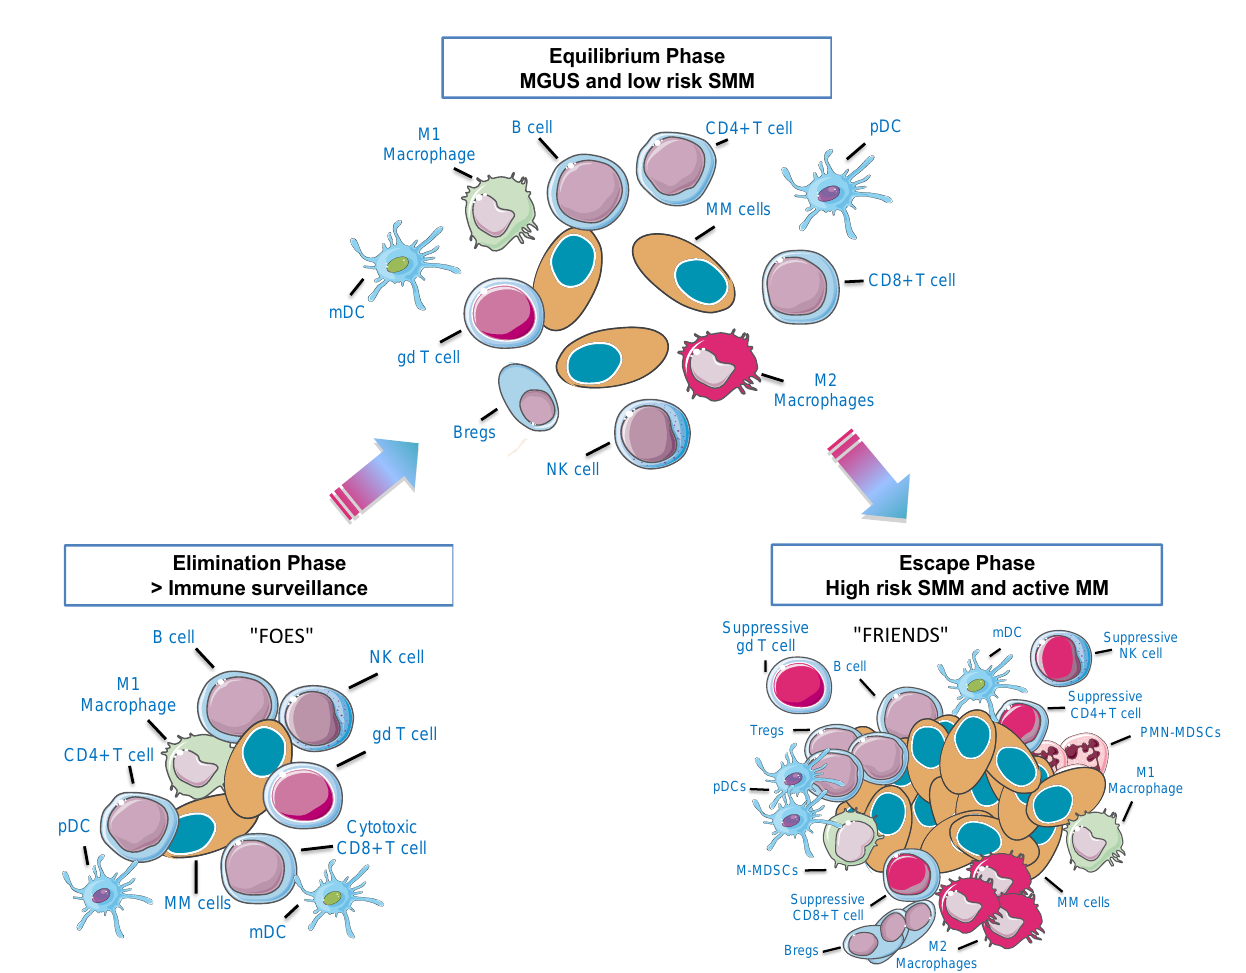
Figure 1. The 3E’s of immunoediting in the multiple myeloma (MM) bone marrow (BM) microenvironment. Immune cells can either eliminate cancer cells or facilitate escape from immune surveillance according to environmental cues. When neoplastic plasma cells start to arise, they can be recognized as strange and be eliminated by immune cells (Elimination Phase—“FOES”). However, cells can reach an equilibrium phase that involves a continuous eradication of myeloma cells. At the same time there is a Darwin selection of the most resistant clones and a decrease of immunogenic tumor cells. This stage is probably the longest phase and may occur over a period of several years, as it happens in monoclonal gammopathy of uncertain significance (MGUS) and low risk smoldering MM (SMM) patients. Afterwards, this novel population of myeloma clones that can model immunity, will grow and expand (Escape Phase—“FRIENDS”). pDC: plasmacytoid dendritic cell; mDC: myeloid dendritic cell, gd: gamma-delta T cells; Bregs: regulatory B cells; Tregs: regulatory T cells; M-MDSCs: monocytic myeloid-derived suppressor cells; PMN-MDSCs: polymorphonuclear MDSCs. Adapted from Dunn et al., 2004